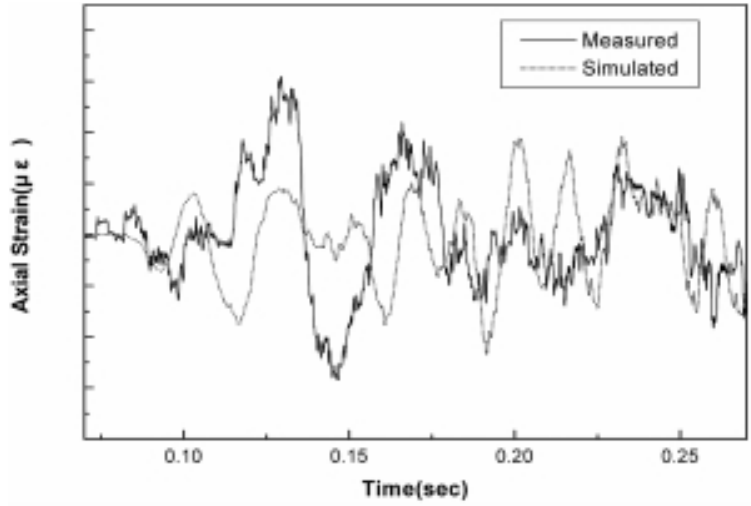
Fig. 14. Comparison of measured and simulated axial strain at mast